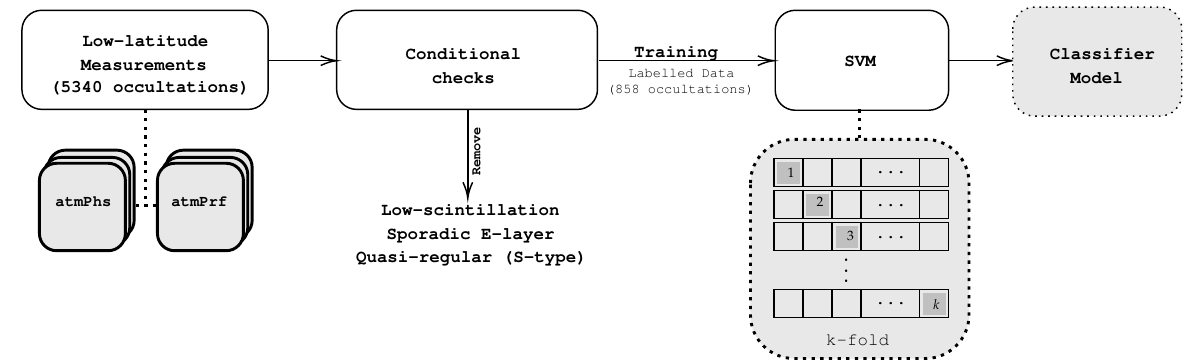
Figure 14. Overview of preprocessing, labelling, and training and testing steps.